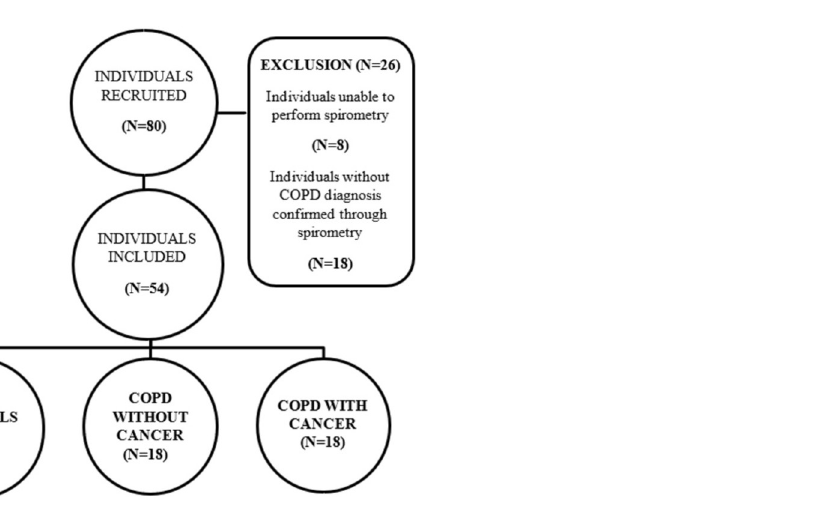
Fig 1. Sample selection and reasons for patient